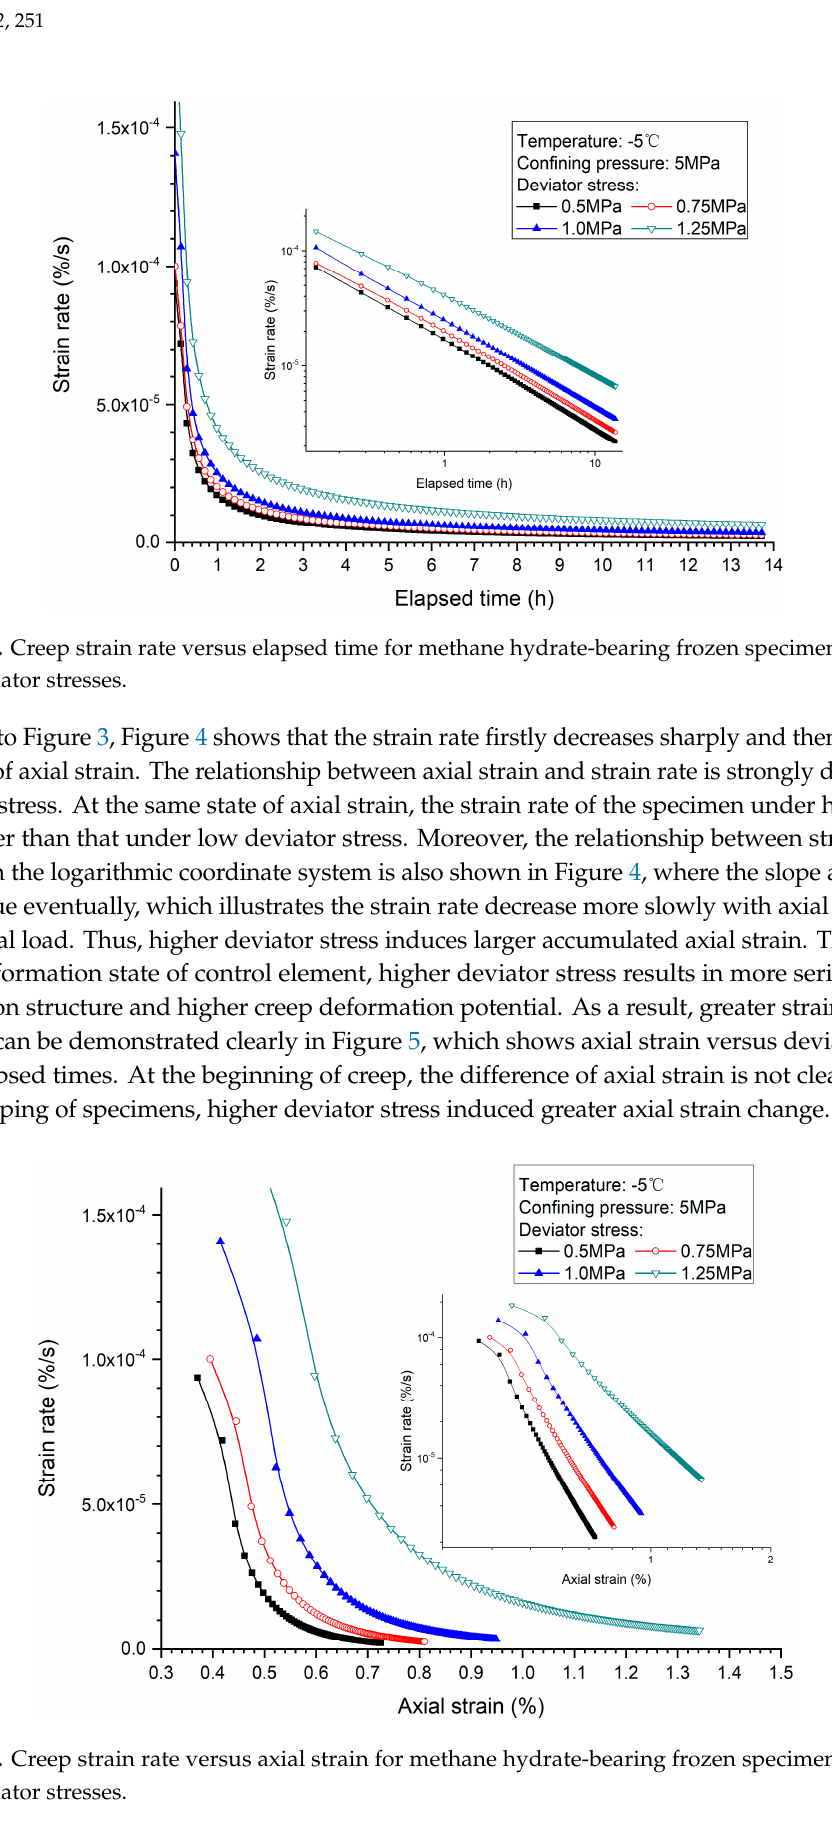
Figure 5. Initial strain and axial strains versus deviator stress for methane hydrate-bearing frozen specimens under low deviator stresses. Creep behaviors of specimens under high stress condition are different from the low stress condition, which has been described above. Figure 2b shows the creep curves of methane hydrate- bearing frozen specimens under different deviator stresses of 2.0 MPa, 3.0 MPa, 4.0 MPa, and 5.0 MPa, with confining pressure of 5 MPa, and temperature of − 10 °C. The curves are straight at the initial phase of the primary stage under high stress condition. The axial strain of the specimen under higher deviator stress is larger and even up to nearly 35%. The damage to the skeleton structure was recovered and the failure of the specimen occurred during creeping tests when deviator stress of 4 MPa or above was applied.